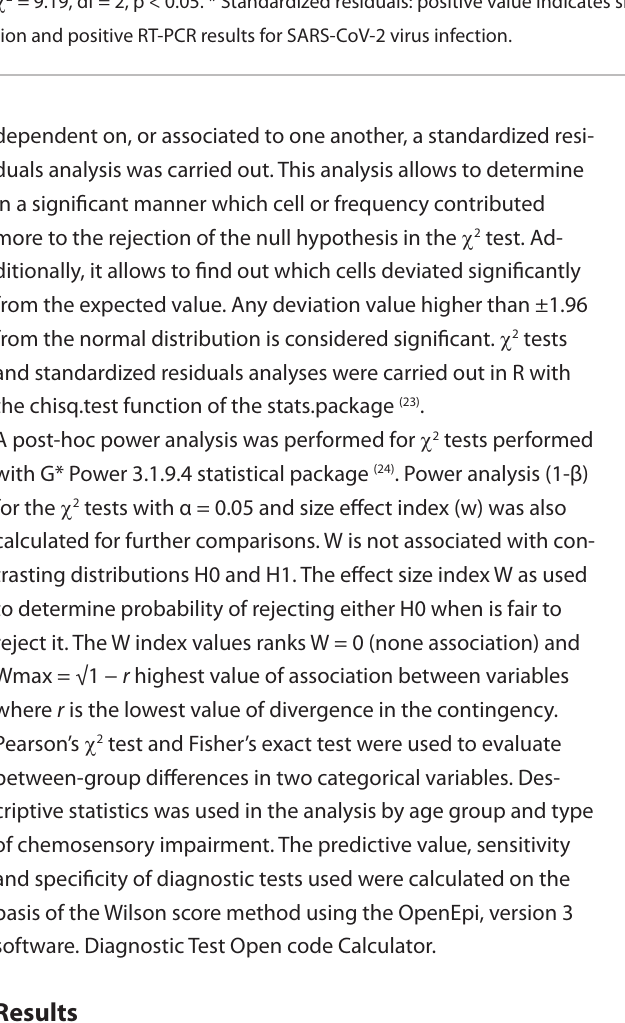
tion and positive RT-PCR results for SARS-CoV-2 virus